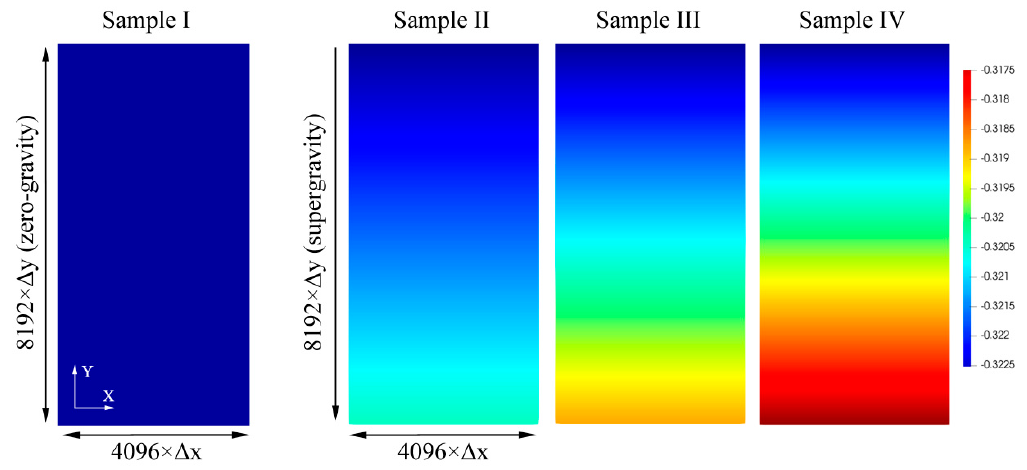
Figure 7. The density φ distribution of sample I–IV in their equilibrium states. The equilibrium state in the zero-gravity field (sample I) is a homogeneous liquid phase, and the density of the liquid phase in the supergravity field (sample II–IV) is distributed on a gradient along the direction of supergravity.